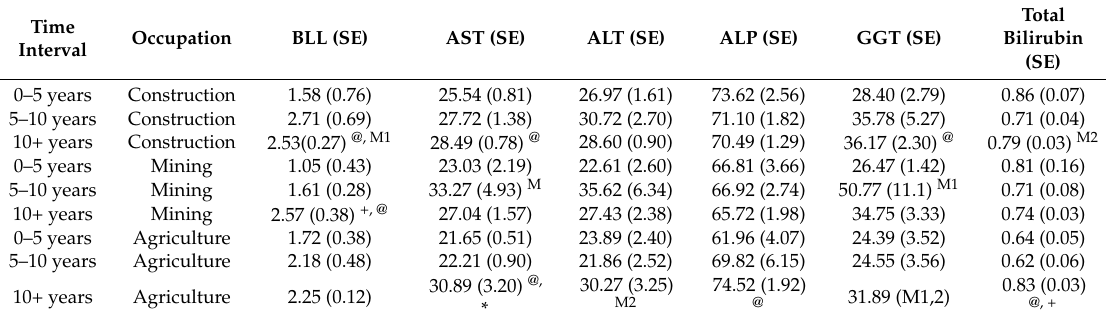
Table 7. Longevity in occupation and clinical